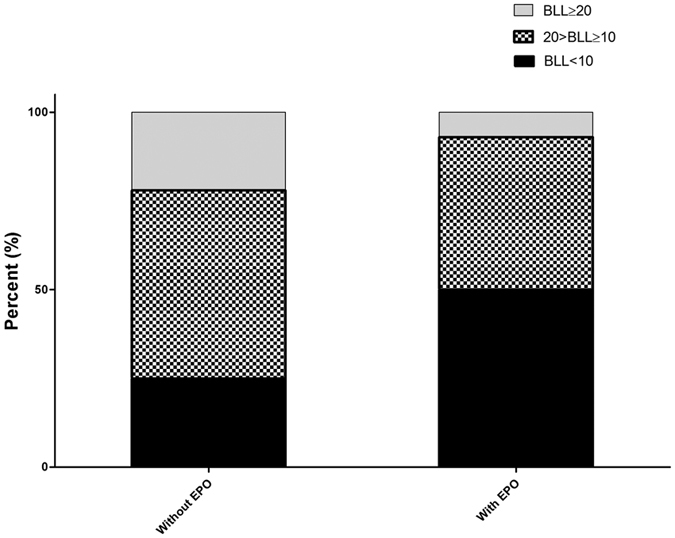
Comparison of percentage of low-normal, high-normal, and high BLL between patients with and without EPO use.In patients with EPO, 50% had low-normal BLL, 43% had high-normal BLL, and 7% had high BLL. In patients without EPO, 25% had low-normal BLL, 53% had high-normal BLL, and 22% had high BLL. *Low-normal BLL, BLL < 10 ug/dL; High-normal BLL, 20 ug/dL >BLL ≥ 10 ug/dL; High BLL, BLL ≥ 20 ug/dL.